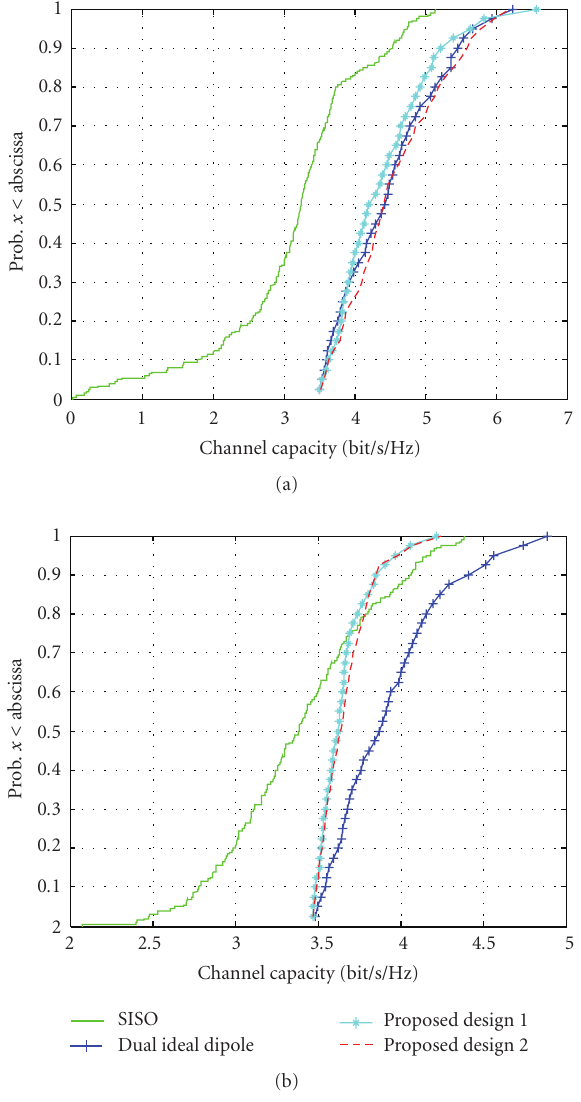
Figure 11: CDFs for di ff erent receiver locations at Room A: (a) Rx1 and (b) Rx2.